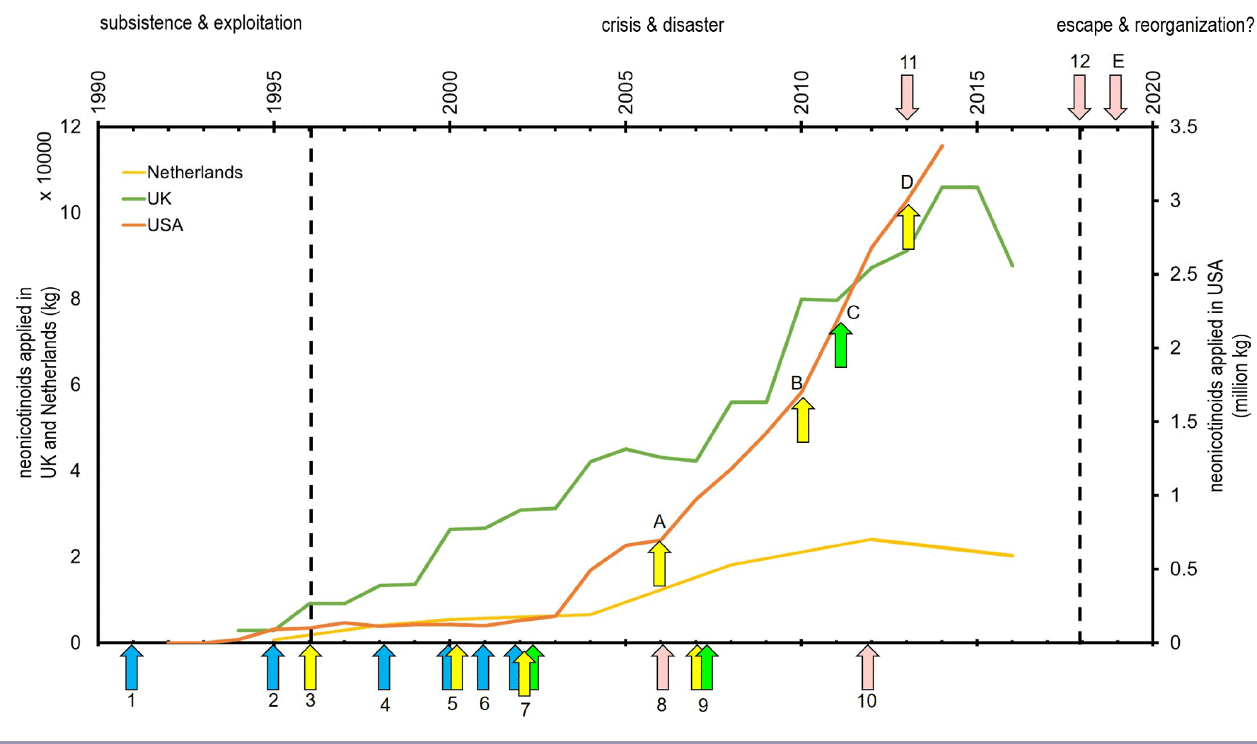
Fig. 4 . Time line of neonicotinoid use and developments from 1990 to the present. The graphs indicate the amount of neonicotinoid use per year, including seed treatments for three countries; USA (orange; million kg applied/year from 1992 to 2014), UK (green; kg applied/ year from 1994 to 2016), and the Netherlands (yellow; kg applied/year from 1995 to 2016). Data are obtained from U.S. Geological Survey (EPest-Low estimate) for the USA (USGS 2019), from Pesticide Usage Surveys for the UK (Fera 2020), and from CBS StatLine for the Netherlands (Statline 2019). Dashed lines indicate the possible timing of the transition to a new phase of the treadmill. Colors referring to domains (I–IV) in the framework: (I) farming (yellow), (II) agro-landscapes (green), (III) science and technology (blue), and (IV) society (pink). Numbers and arrows indicate drivers of the treadmill; (1) introduction of imidacloprid; (2) introduction of acetamiprid and nitenpryam; (3) neonicotinoid resistance in B. tabaci ; (4) introduction of thiamethoxam; (5) introduction of thiacloprid (blue), neonicotinoid resistance in Leptinotarsa decemlineata (Colorado potato beetle; yellow); (6) introduction of clothianidin; (7) introduction of dinotefuran (blue), honeybee mortality linked to neonicotinoids (green), neonicotinoid resistance in A. gossypii (yellow); (8) patent expiry on imidacloprid; (9) neonicotinoid resistance in N. lugens and M. persicae (yellow), 80% seed treatments with neonicotinoids (green); (10) patent expiry other neonicotinoids; (11) two year moratorium on three neonicotinoids in EU; (12) ban on three neonicotinoids in EU. For USA specifically: (A) imidacloprid resistance in L. decemlineata ; (B) imidacloprid and thiamethoxam resistance in M. persicae and B. tabaci ; (C) more than 50% of area planted with maize, soybean, and cotton treated with neonicotinoids; (D) thiamethoxam resistance in A. gossypii ; (E) registration review update in the